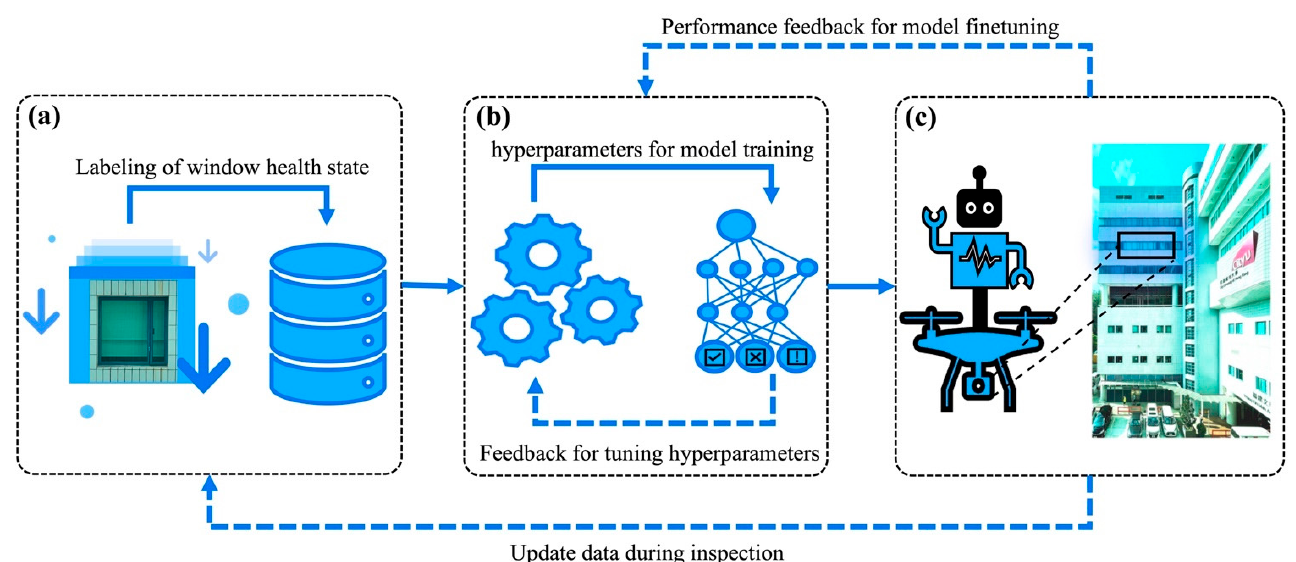
Figure 5. Blueprint for smart window inspection scheme using artificial intelligence technologies. ( a ) Data collection and image label. ( b ) Training model for inspecting aluminum window health state, namely recognizing broken window glass, corroded window frame, and life expectancy prediction. ( c ) Application of the trained model on drones. The images gained in the inspection process can enrich the dataset, and the model performance can provide feedback for the fine-tuning model.